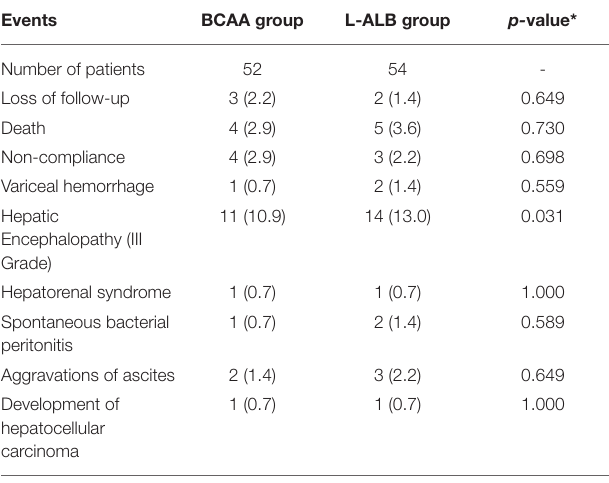
TABLE 3 | Incidence of major cirrhosis related events in BCAA and L-ALB